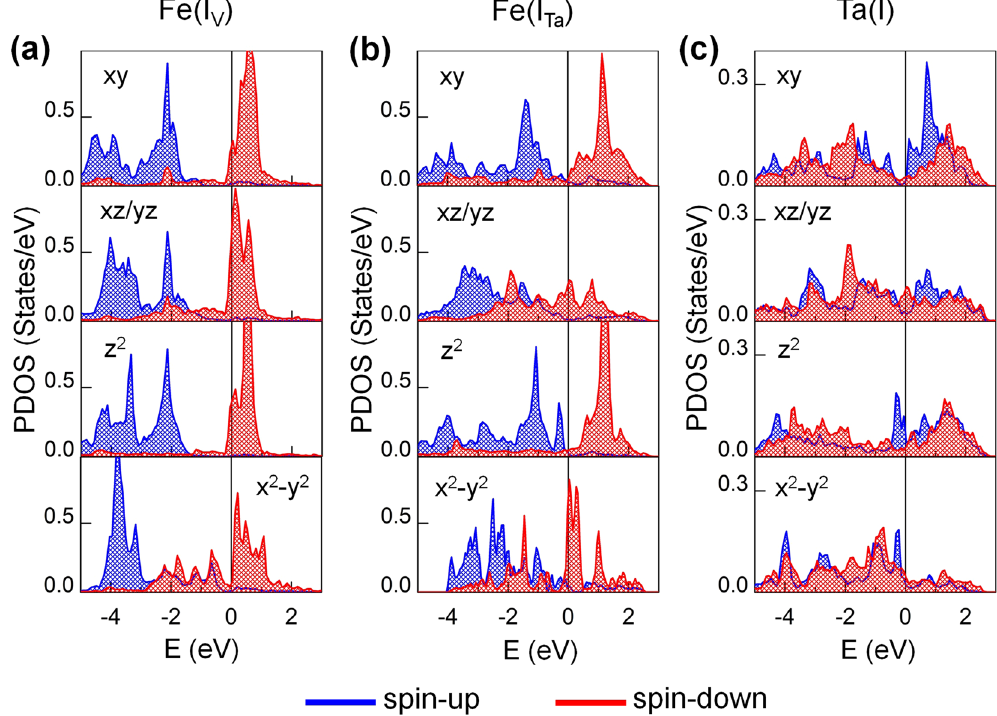
Figure 3. Spin and d -orbital decomposed PDOS of ( a ) Fe(I V ) in FeRh/MgO and ( b ) Fe(I Ta ) and ( c ) Ta(I) in Ta/FeRh/MgO multilayers. The blue and red areas represent the majority-spin and minority-spin states, respectively. The Fermi energy is set to zero energy.